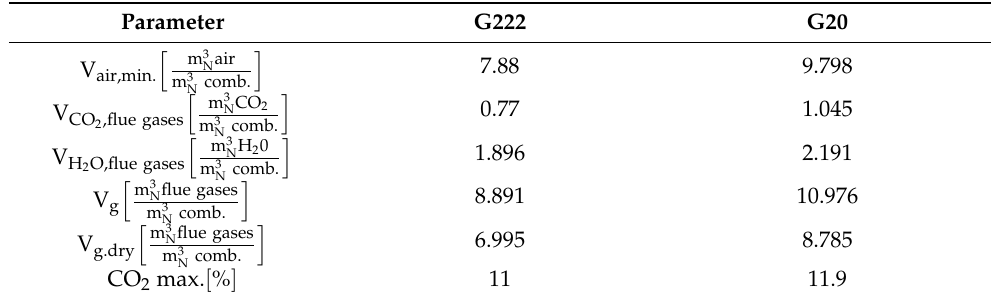
Table 4. Calculated values for determining the maximum CO 2 percentage in flue gases (CO 2